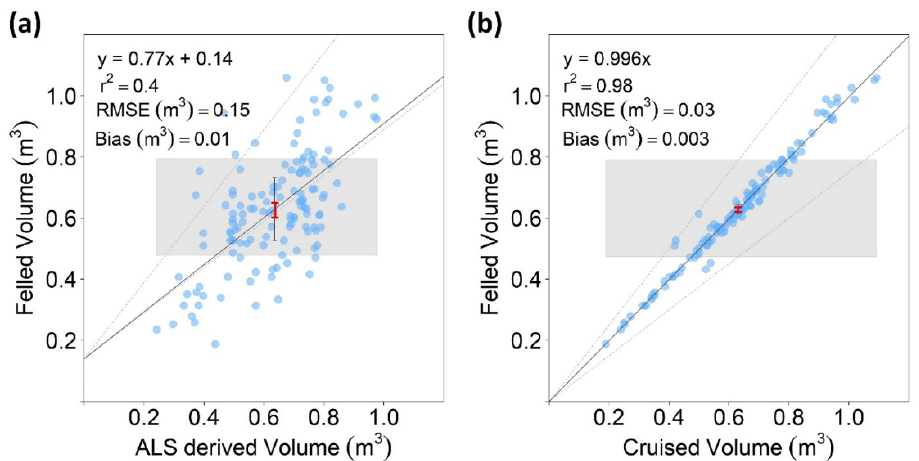
Figure 8. Equivalence test graphs for felled tree volume versus ( a ) ALS-derived volume and ( b ) cruised volume. The grey polygon represents the ±25% region of equivalence for the intercept. The ALS-derived and cruised volume are equivalent to the felled volume when the vertical red bar is completely within the grey polygon. The grey dashed lines represent the ±25% region of equivalence for the slope. If the vertical black bar is within the grey dashed lines, then the regression slope is significantly similar to 1. The solid black line represents the best-fit linear regression model.